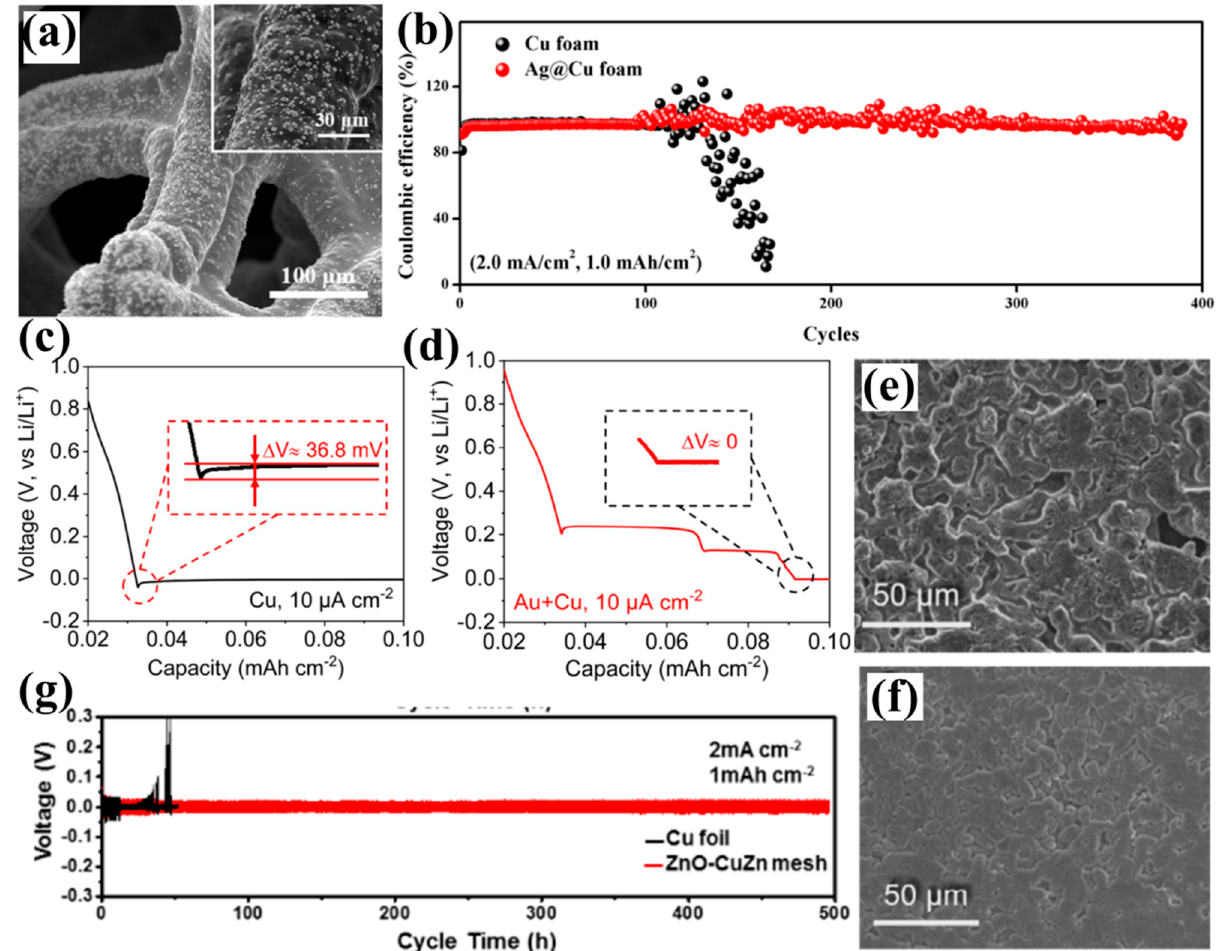
Figure 3. ( a ) SEM images of Ag@Cu foam with plated silver for 10.0 s; ( b ) Coulombic efficiencies of Ag@Cu and Cu foam at 2.0 mA cm − 2 [40] . Copyrights © 2022 Published by Elsevier. Discharge voltage curves of ( c ) Li||Cu, and ( d ) Li||Au/Cu batteries at 10 μ A cm − 2 , 0.1 mAh cm − 2 ; the SEM images of Cu foil surface in the Li 2 S||Cu cell, and ( e ) Cu/Au foil surface in the Li 2 S||Au/Cu cell ( f ) for the first cycle at 0.05 C [41] . Copyrights © 2022 Published by Elsevier. ( g ) Voltage profiles of the ZnO − CuZn mesh and Cu foil in symmetrical ba tt eries at 2 mA cm − 2 and 1 mA h cm − 2 [42] . Copyrights © 2022 American Chemical Society.